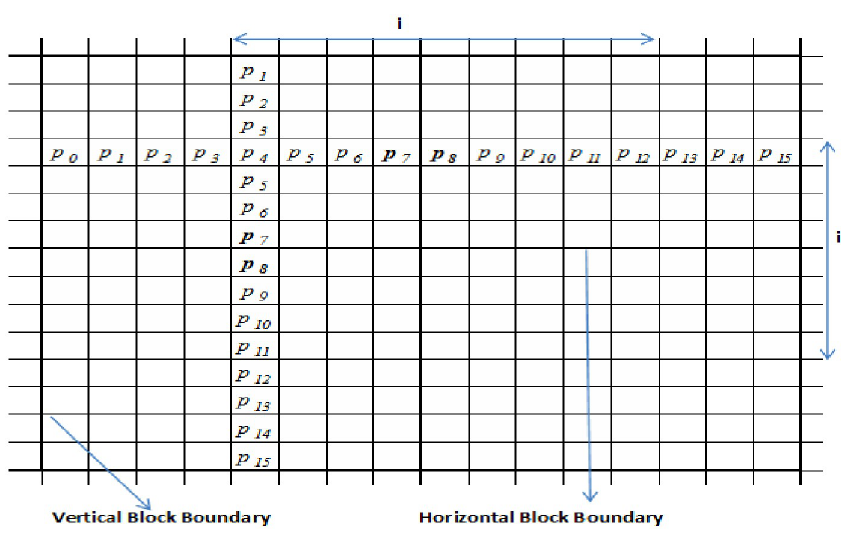
Fig 3. Pixel Vector (PV) and block boundaries for determining region using the activation function of symmetrical 8x8 block of a de-blocked video frames.